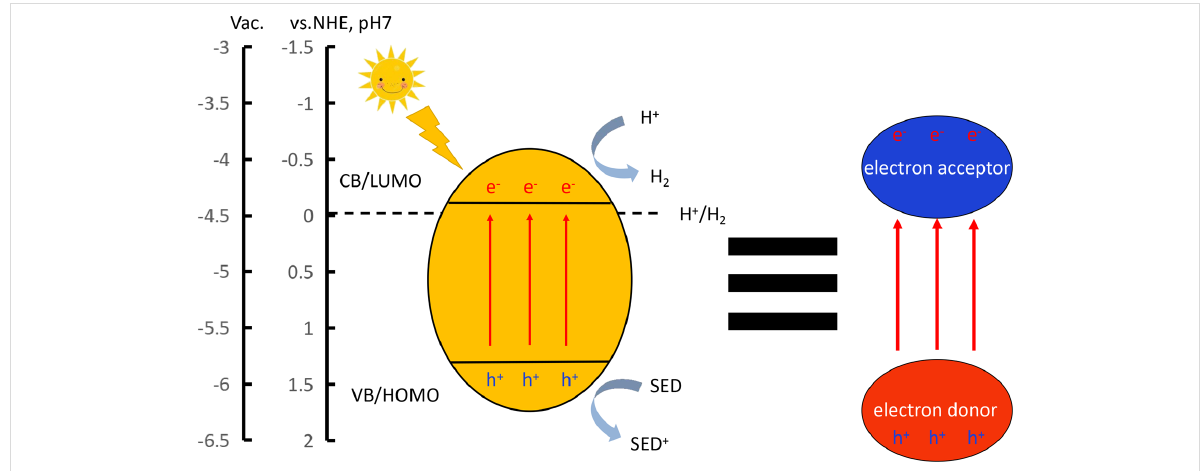
Figure 1: (Left) Schematic diagram of the mechanism of semiconducting catalyst-mediated photocatalytic hydrogen production (CB: conduction band, VB: valence band, SED: sacrificial electron donors). (Right) Charge separation in a CP-based semiconductor via photoinduced D → A charge transfer.